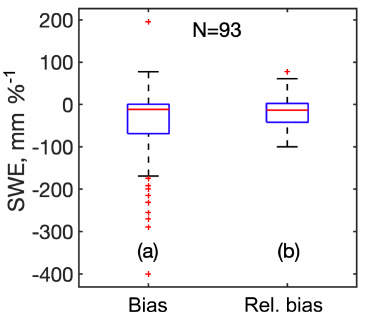
Figure 5. Bias (a) and relative bias (b) for ParBal reconstructed SWE vs. Alpine3D-modeled SWE at AKAH stations on the median peak SWE date for both years, where bias here is ParBal SWE and Alpine3D SWE.